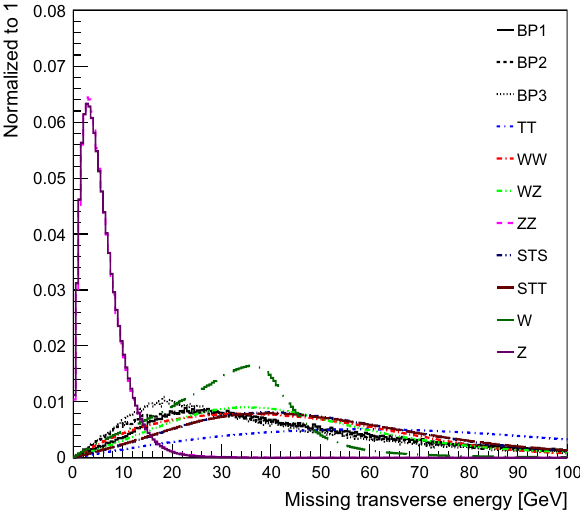
Fig. 8 The distribution of missing transverse energy in signal ( (cid:2)(cid:2) H (cid:2)ν H ) and background events